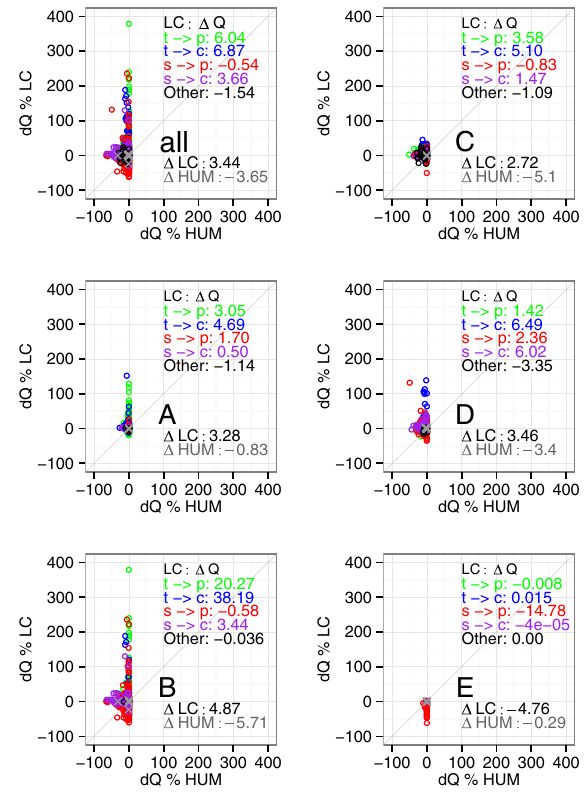
Figure A6. River discharge ( Q ) changes in percentage per subbasin for all Köppen classes (in the top left) as well as per Köppen class. Change due to human water use is represented on the x axis (HUM, (HUM2000 − LC2000) · 100 / LC2000), and change due to land cover change is given on the y axis (LC, (LC2000 − LC1850) · 100 / LC1850). Each circle color represents a land cover change: tall to pasture (green), tall to crop (blue), short to pasture (red), short to crop (purple) or other (black, crop or pasture to short or tall natural). Gray crosses represent subbasins where no land cover change occurs. Köppen class A is equatorial, B is arid, C is warm temperate, D is snow and E is polar climates. In each panel the top-right numbers are the average discharge change per land cover change in percentage, and in the bottom right are the total land cover changes as well as the changes due to human water use in percentage. Areas and number of subbasins per land cover change are given in Table 2. One subbasin in B, short to pasture, was removed from this figure; with very low Q ( < 1m 3 s − 1 ), d Q in this basin became > 1000%. Figure 8 shows the absolute